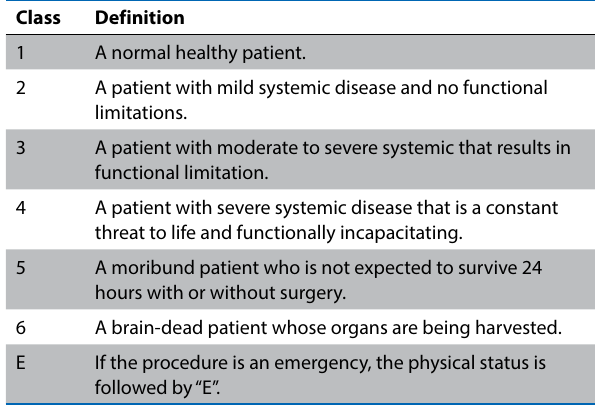
Table 3. Pre-operative physical status classification of patients according to the